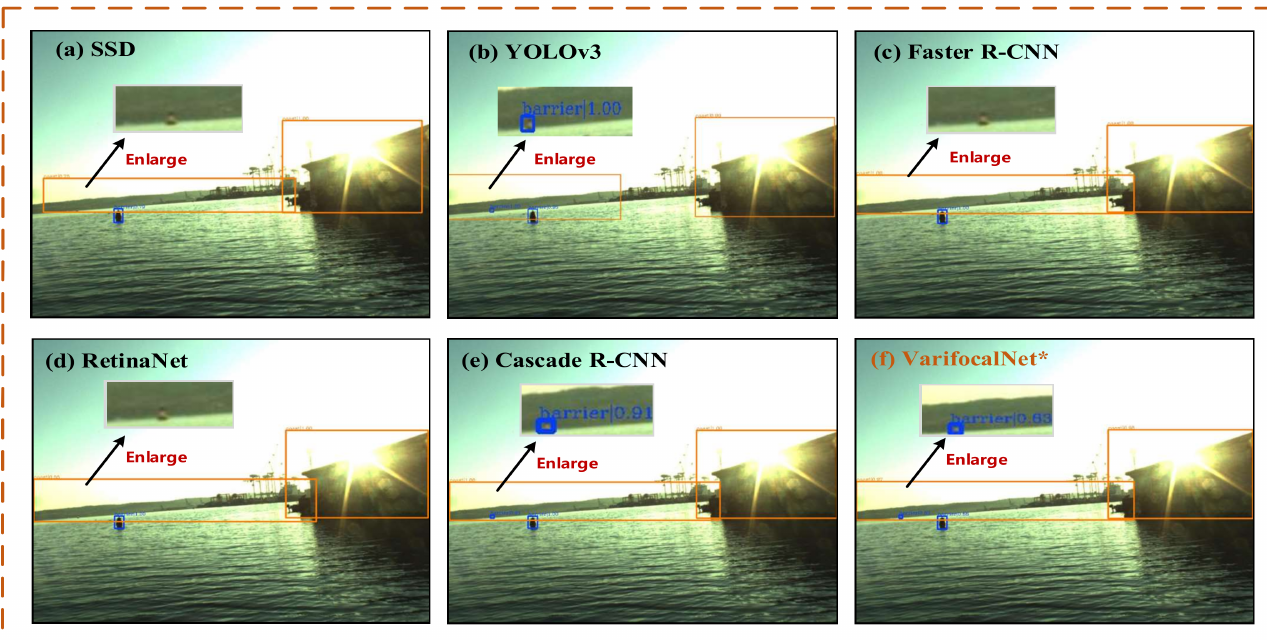
Figure 13. The visual comparisons of different competing methods for detection of sea-surface obstacles under strong sunlight interference. In ( a , c , d ), Small scale objects are not detected using SSD, Faster R-CNN, RetinaNet methods. In ( b ), incomplete coasts are detected using YOLOv3 method. Cascade R-CNN and VarifocalNet * methods can better adapt to strong light scenes at sea, as shown in ( e , f ).